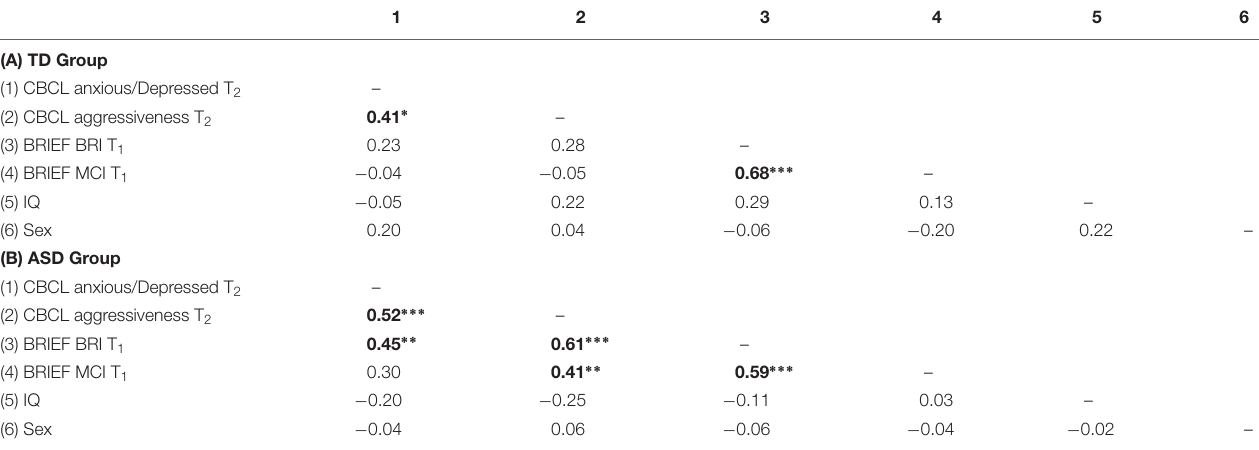
TABLE 2 | Correlation matrixes of EF variables and emotional and behavioral functioning variables for (A) TD children and (B) children with ASD. 1 2